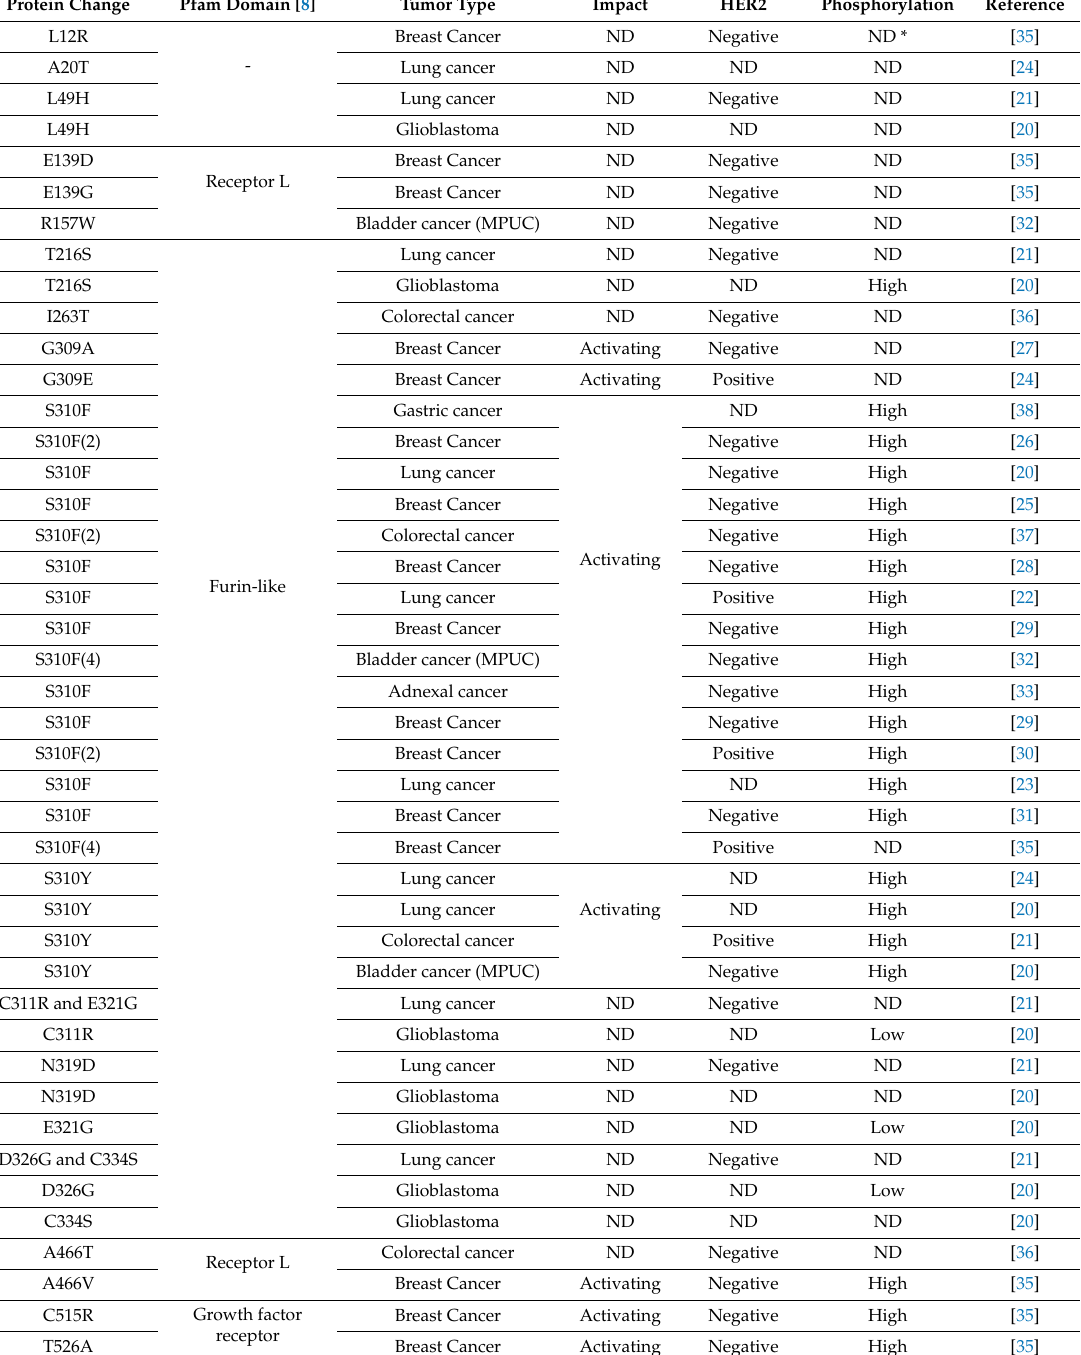
Table 1. Human epidermal growth factor receptor 2 (HER2) extracellular domain mutations reported in previous studies from patient